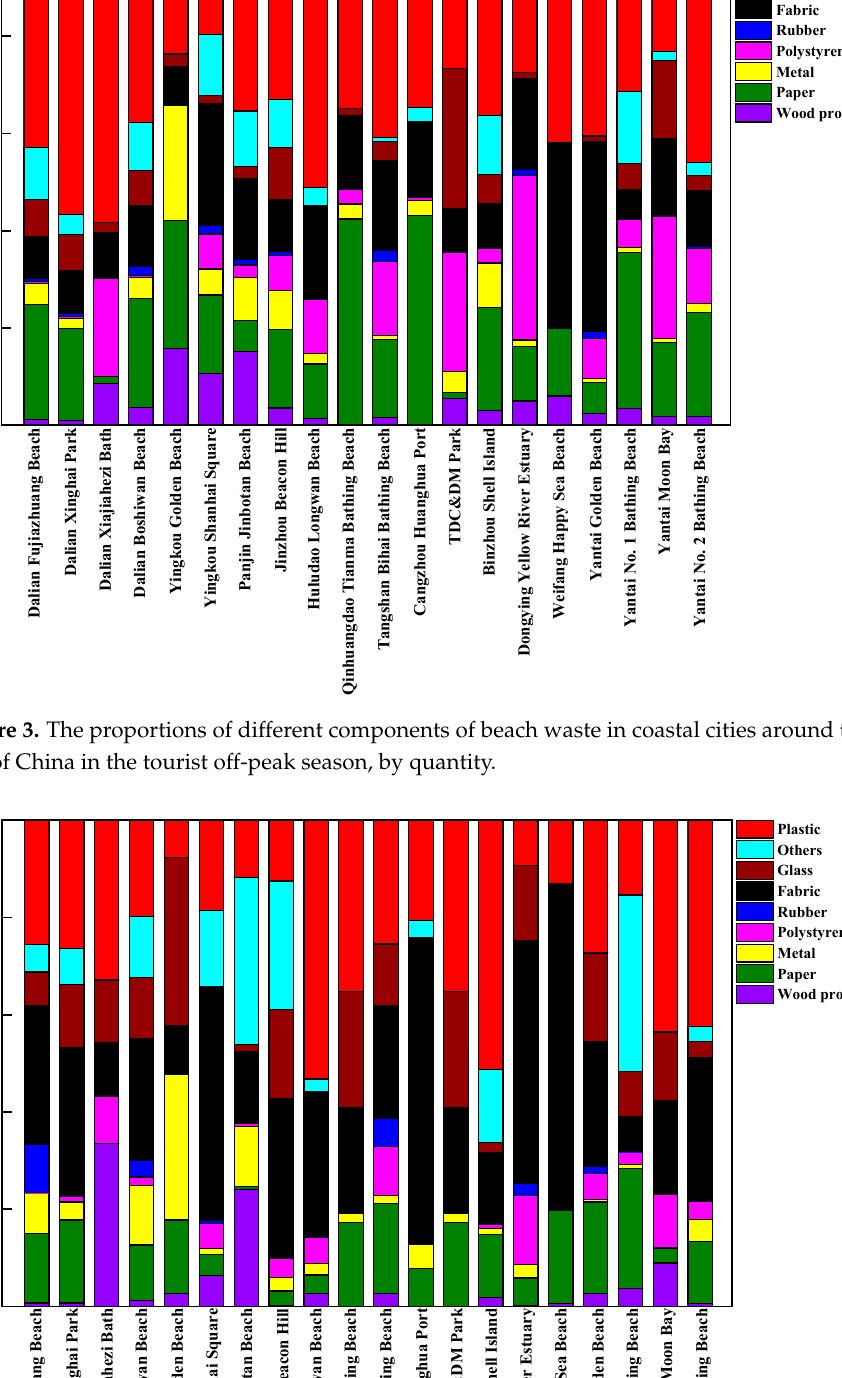
Figure 5. The proportions of different components of beach waste in coastal cities around the Bohai Sea of China in the tourist peak season, by quantity.